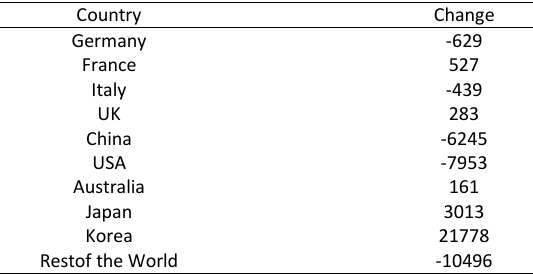
Table 2: Change in trade balances (US million of dollars) Country